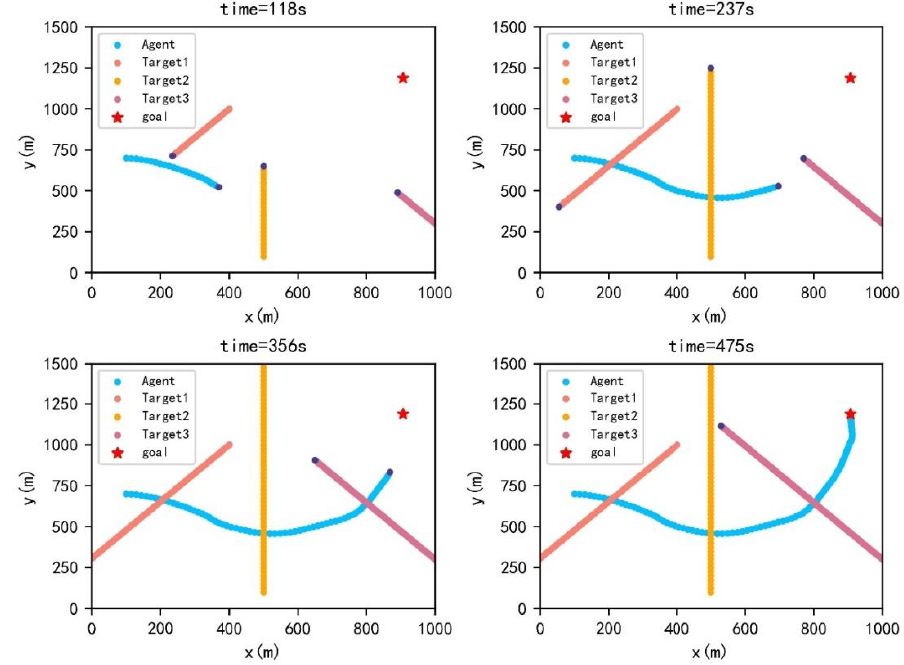
Figure 9. Trajectories when 𝑤 = 0.9.